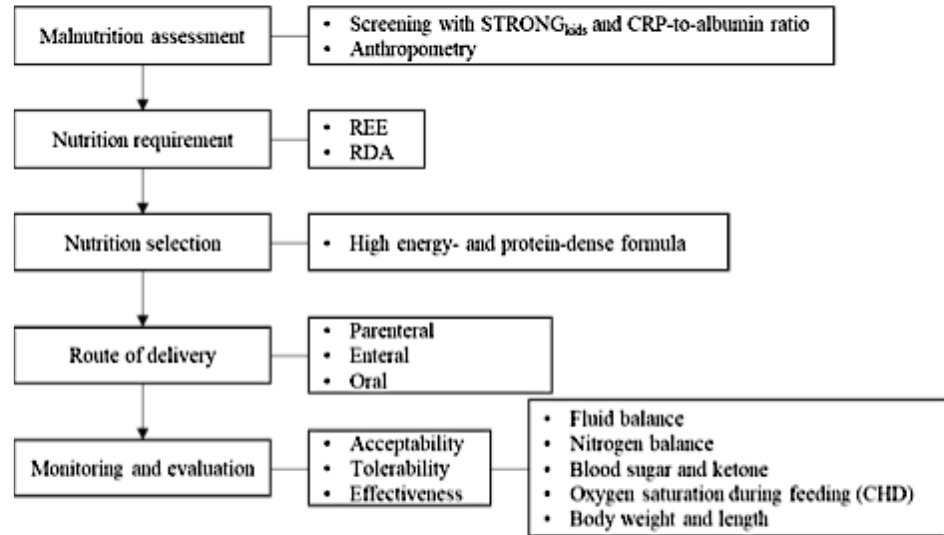
Figure 2. Algorithm for disease-related malnutrition management in pediatric patient with congenital heart disease and cancers 26-30 CHD: congenital heart disease; CRP: C-reactive protein; RDA: recommended dietary allowance; REE: resting energy expenditure; STRONG for risk on nutritional status and